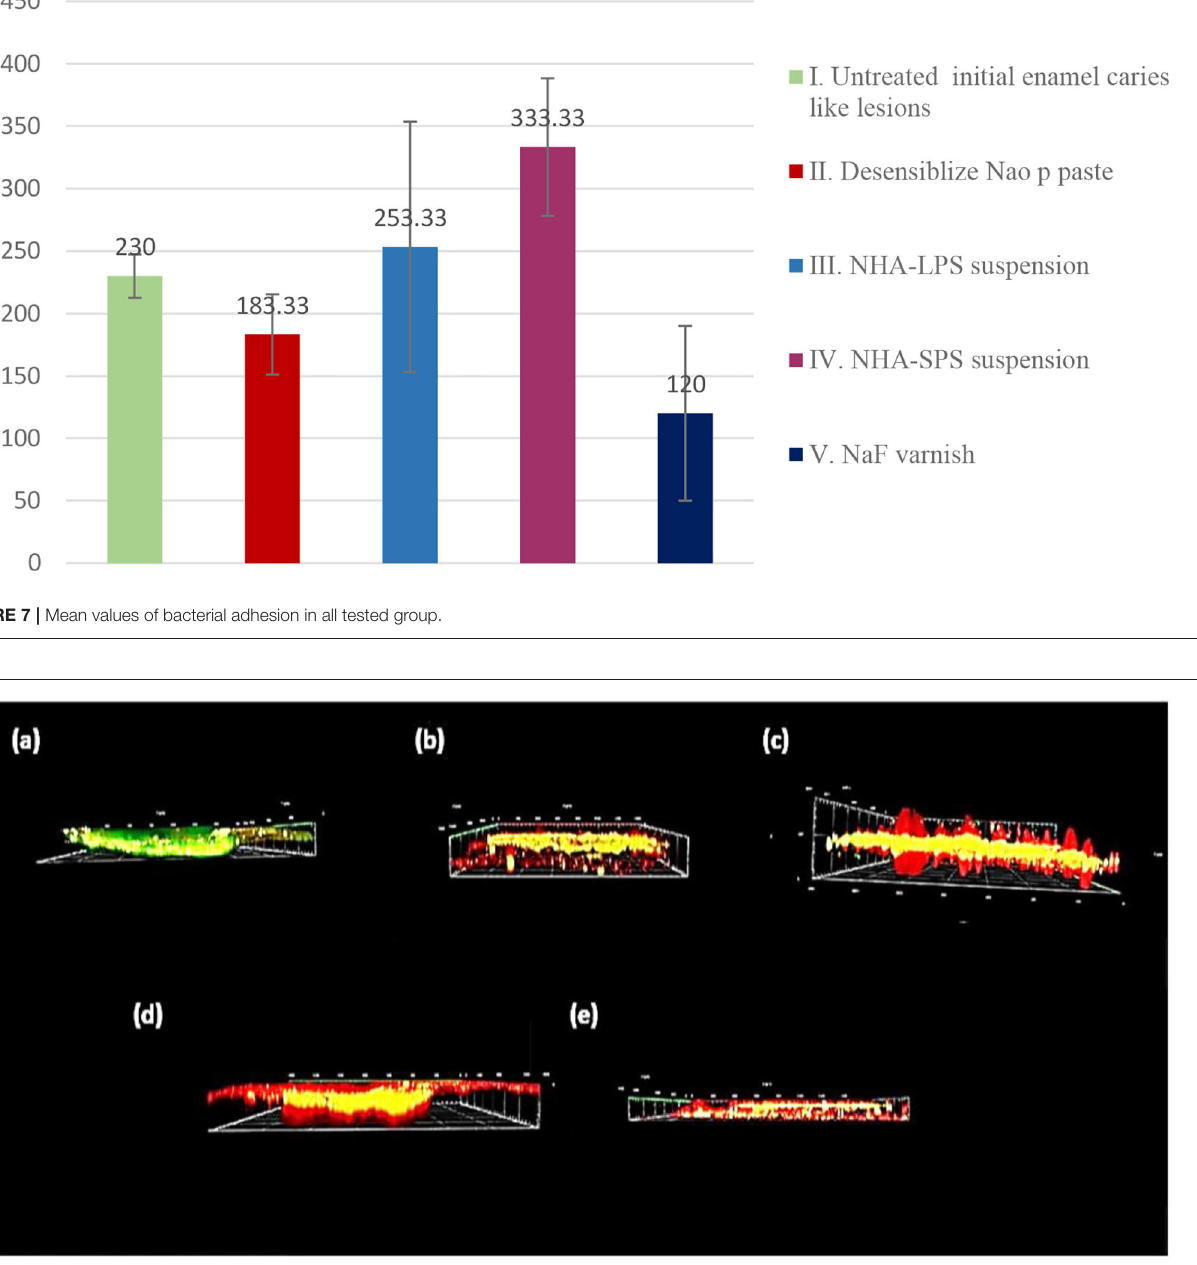
FIGURE 8 | Side view of confocal scanning microscopic images of biofilm thickness obtained from virtual addition of multiple horizontally captured images at different depth levels. (a) Untreated enamel caries like lesions (group I), (b) desensibilize nano p (group II), (c) NHA-LPS suspension (group III), (d) NHA-SPS suspension (group IV), and (e) na F varnish (group